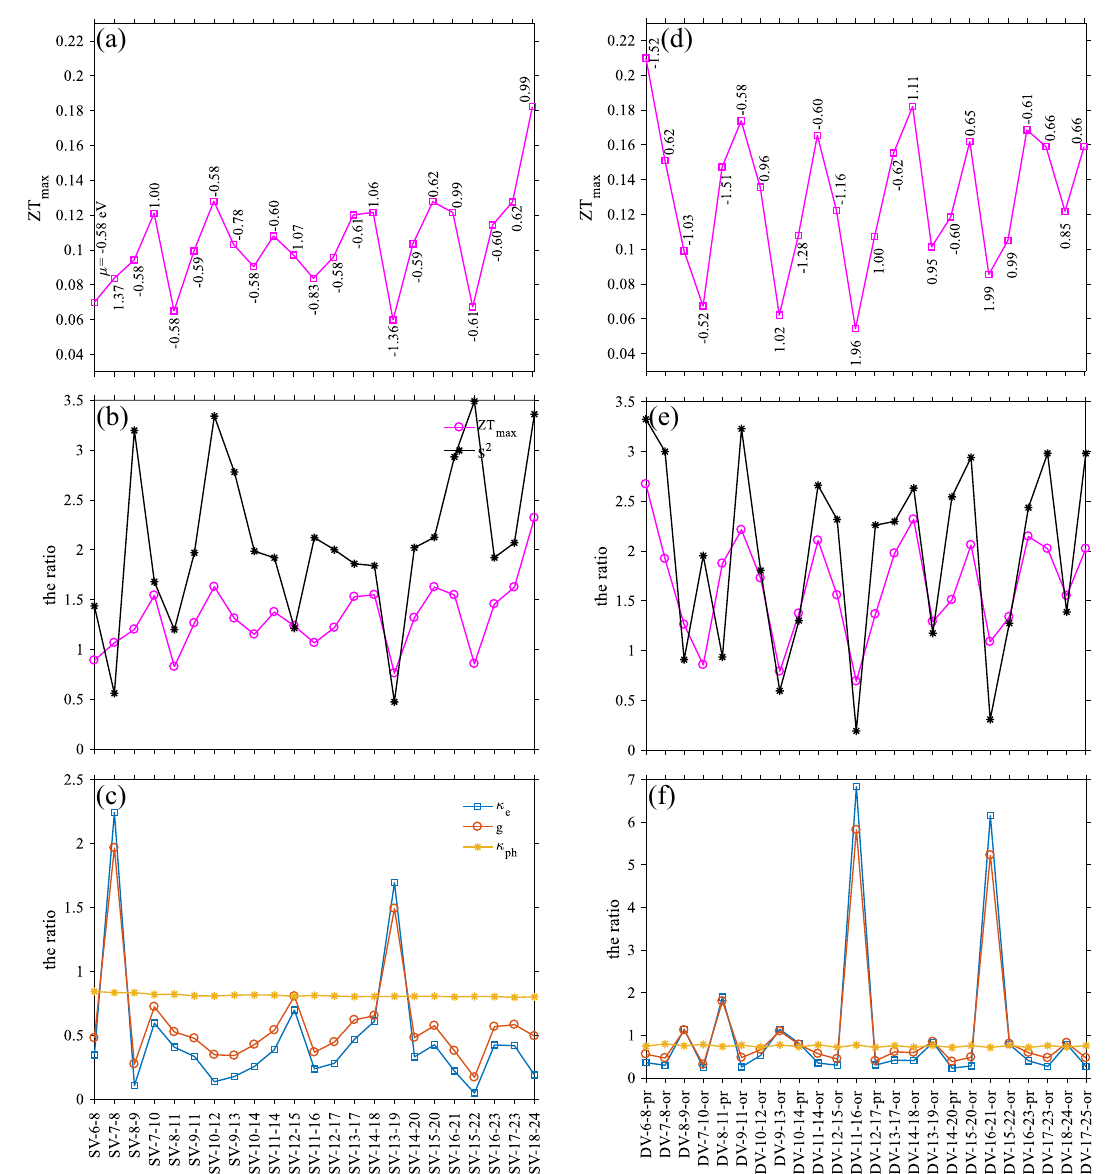
Figure 4. ( a ) Highest figure of merit variation and the corresponding µ respect to the SV locations (as described in the text), ( b ) the ratio of the Seebeck coefficient square and the maximum ZT, ( c ) the ratio of the electronic and phononic terms as a function of the SV locations for the S-shape ZGNR with a length of Å, ( d ) the ZT max and its corresponding chemical potential as a function of different DV locations, ( e ) the ratio of the Seebeck square and the maximum of ZT, and ( f ) the ratio of electronic and phononic terms versus the DV